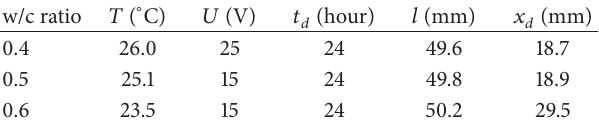
Table 4: Parameters measured in RCM test of cement pastes.